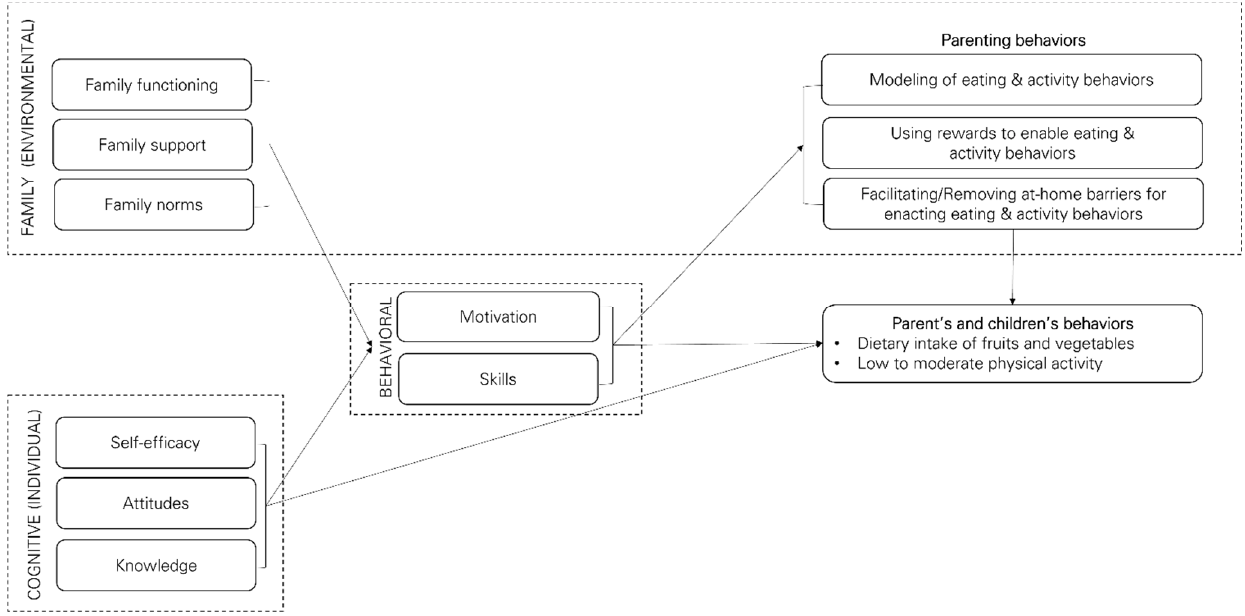
Figure 1. Conceptual model for multilevel behavioral program the ¡Haz Espacio para Papi! (HEPP, Make Room for Daddy!) A detailed description of the theoretical foundation for this conceptual model is provided in the section called Theoretical Foundation. This conceptual model includes multi-level factors at the individual, behavioral, and environmental levels.